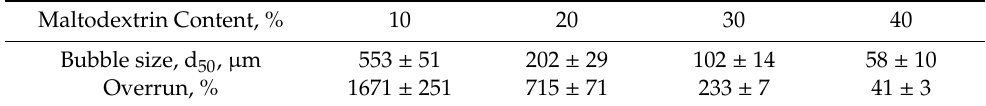
Table 2. Bubble size d 50 and overrun of polysorbate 80 foam at di ff erent maltodextrin concentrations. Maltodextrin Content, %